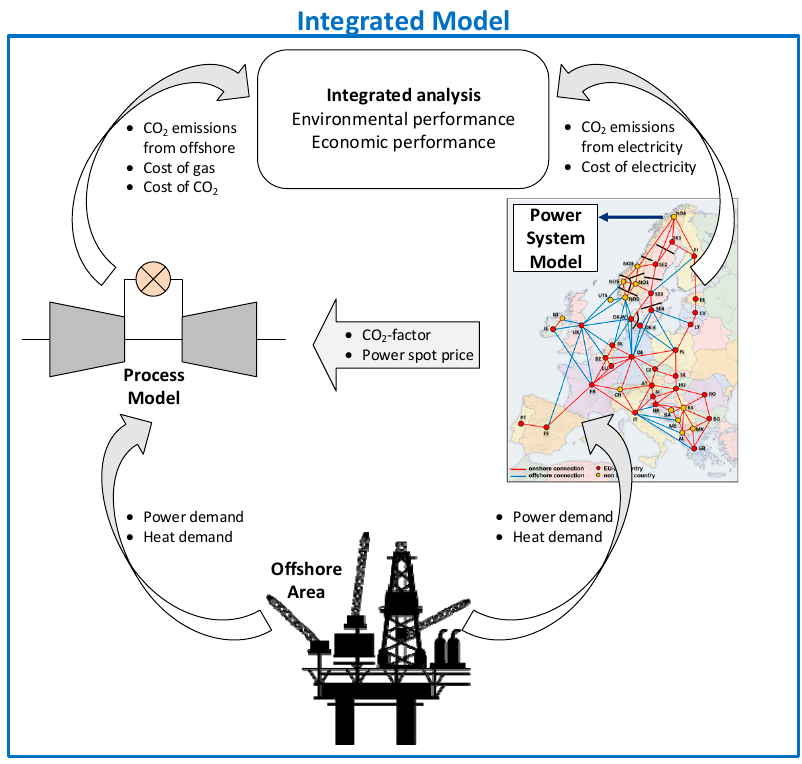
Figure 6. Representation of the integrated method developed for the analysis.